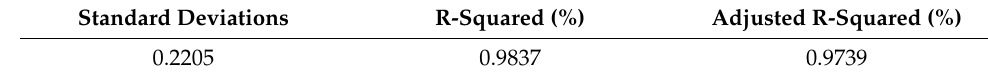
Table 7. Adequacy of the model.